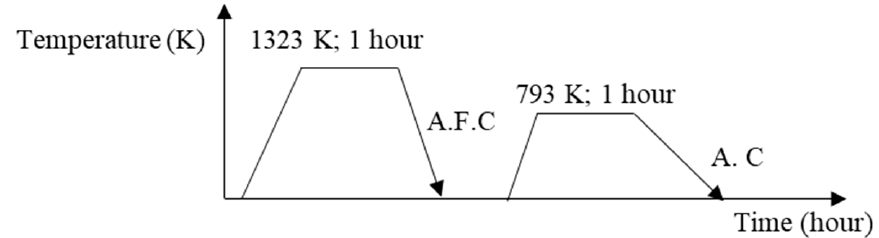
Figure 1. The schematic of the destabilization heat-treatment process for each specimen.